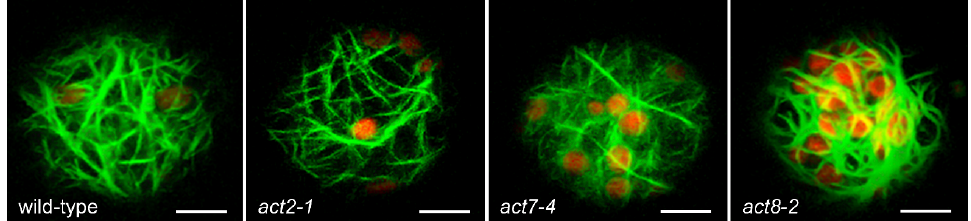
Figure 3. Actin networks in wild ‐ type and act mutants. Images are maximum projections of optical sections (4 μ m deep) of 48 ‐ h protoplasts derived from wild ‐ type (Col ‐ 0) and act mutants expressing GFP ‐ fABD2. Red is chlorophyll autofluorescence from chloroplasts. Scale bars = 10 μ m.